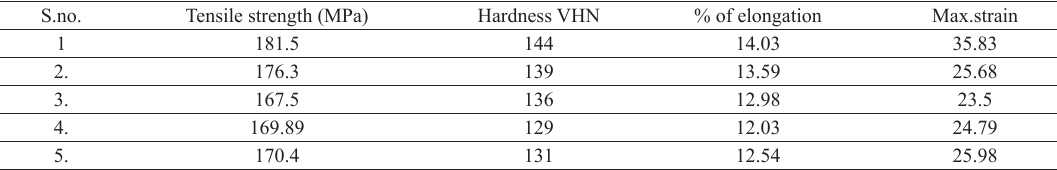
Table 2. Mechanical properties of the welded